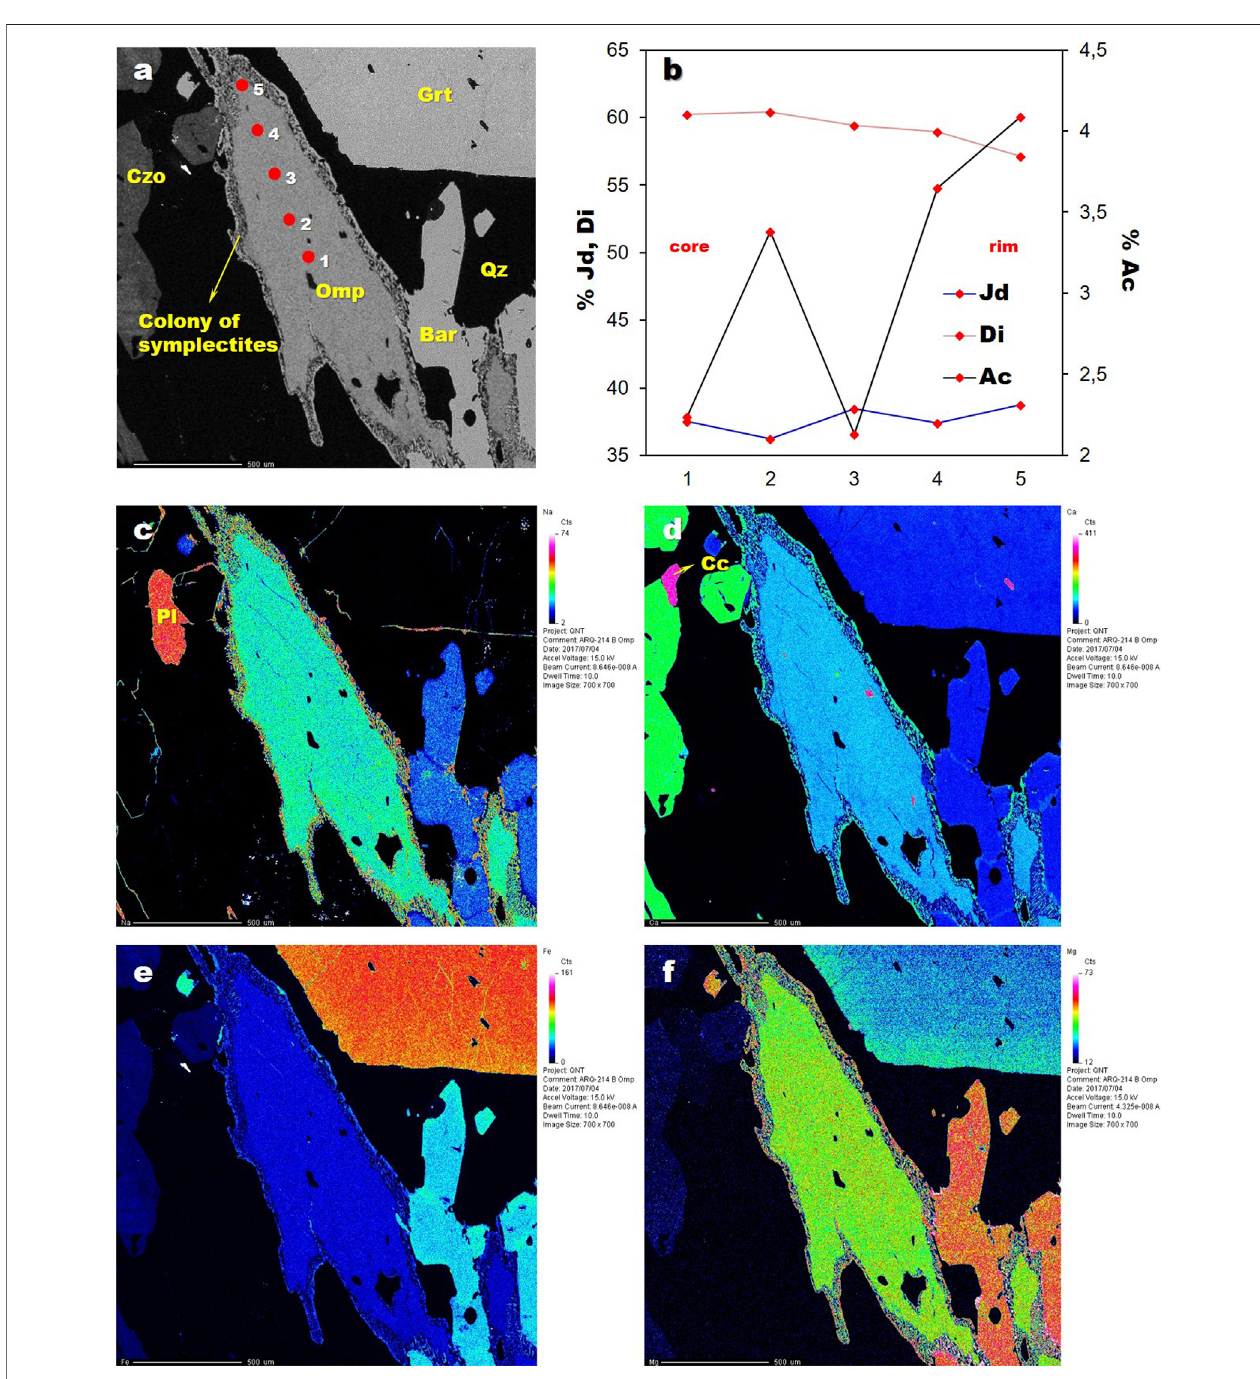
FIGURE 4 | (A) Back-scattered electron image of omphacite surrounded by a colony of symplectites, showing the spot reference for mineral composition analysis. (B) Compositional pro fi le across omphacite from core to rim. (C – F) X-ray mapping of Na, Ca, Fe and Mg for omphacite. Red shows areas of high concentration, bluerepresentsareasof low concentration and black represents areas ofvery low concentration. Omp, Omphacite; Grt, garnet; Brs, barroisite; Czo, clinozoisite; Qz, quartz.